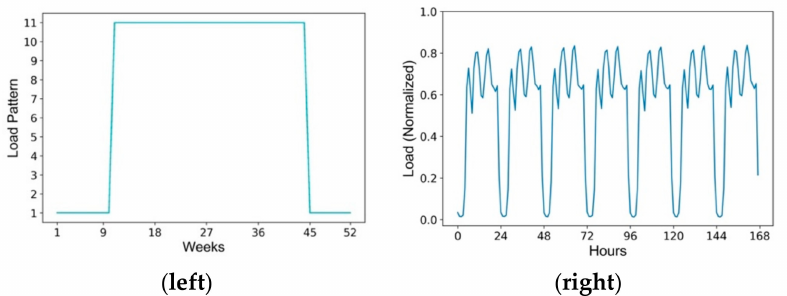
Figure 10. Typical user behaviors of catering industry ( left ) and corresponding load patterns in short-term ( right ).